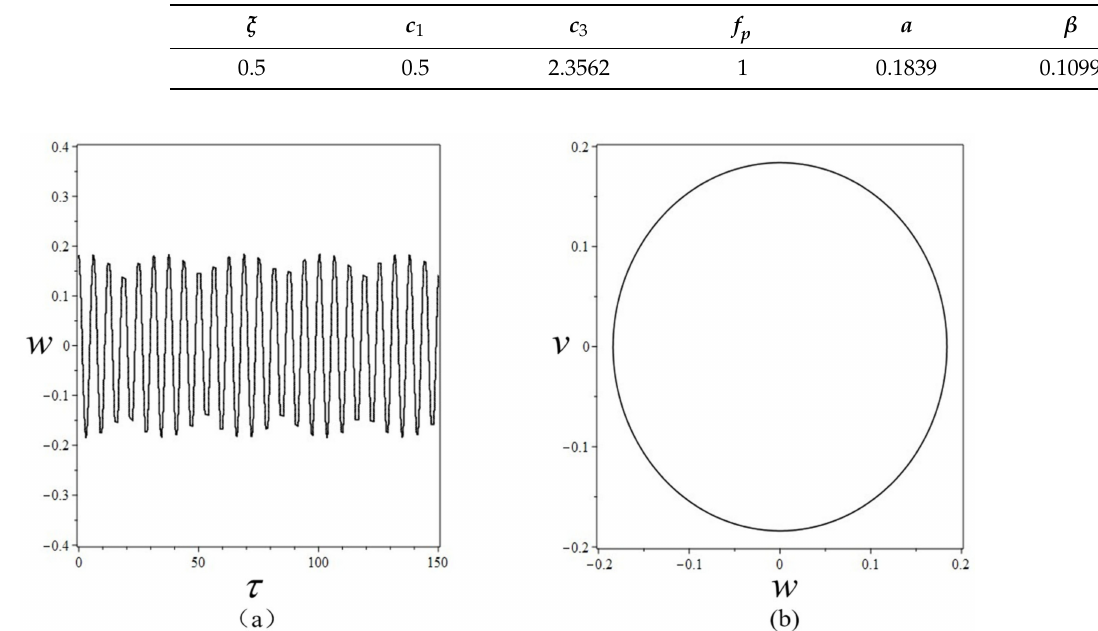
Table 3. Superharmonic resonance dynamic response parameter table.